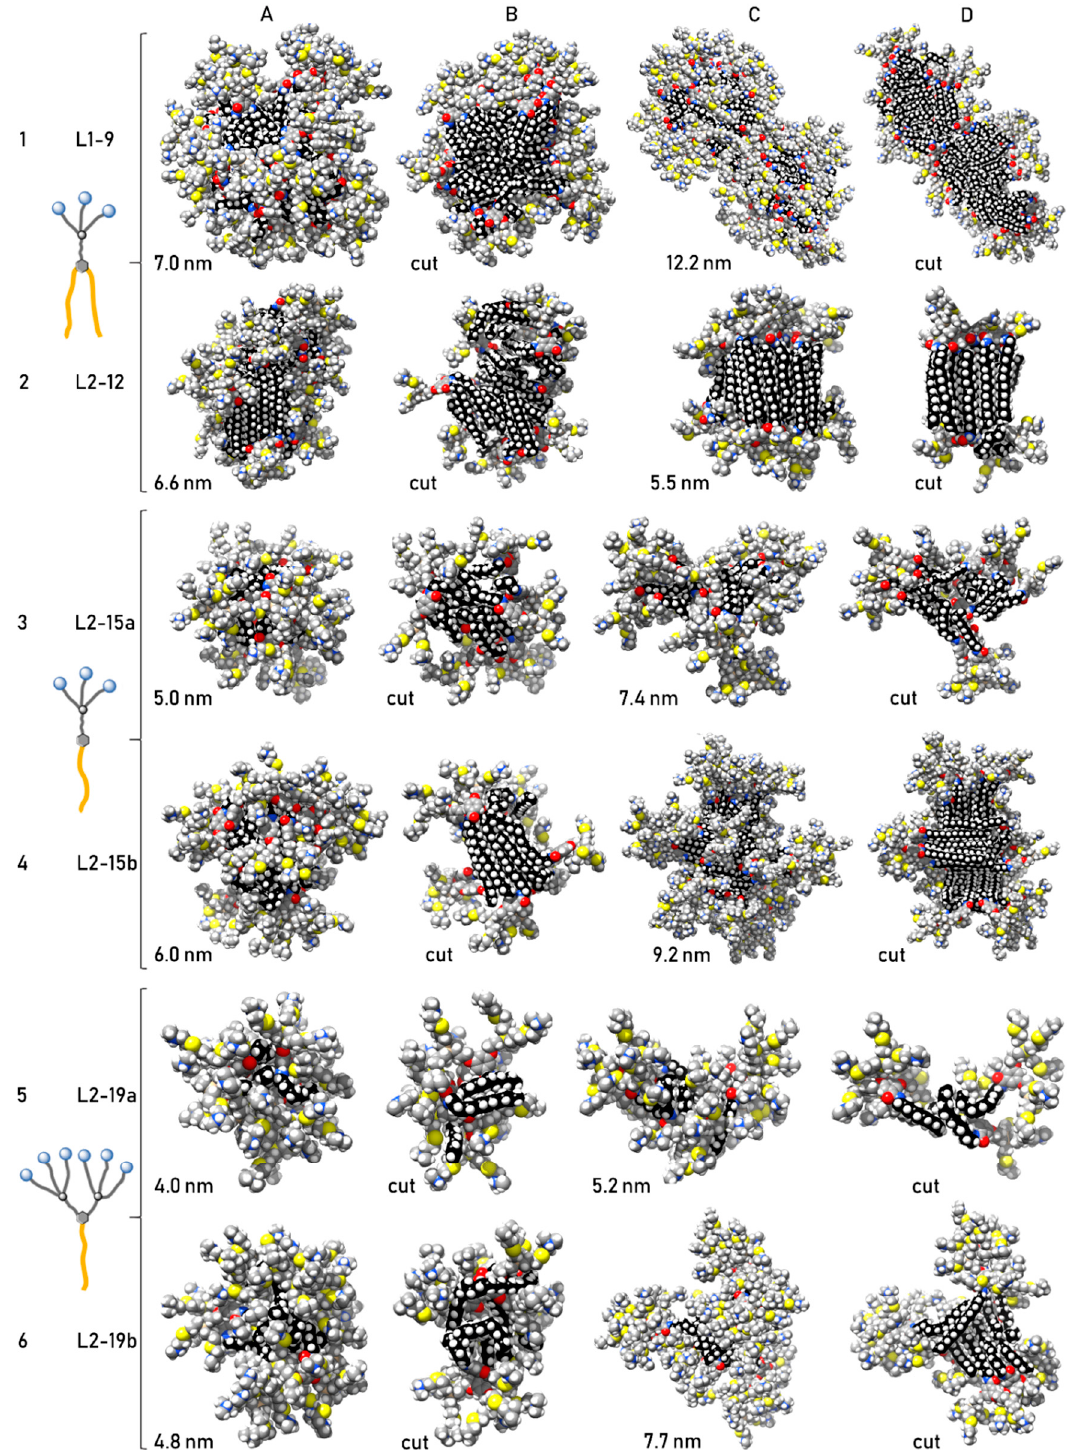
Figure 1. Typical micellar structures composed of ammonium-terminated dendrons L1 – 9 , L2 – 12 , L2 – 15a , L2 – 15b , L2 – 19a and L2 – 19b (lines 1–6 in that order), obtained from molecular dynamics simulations. For each dendron, two representative micellar structures are shown (columns ( A , C )). Each dendron cluster is appended by its cut (on the right from cluster figure; columns ( B , D )), realized by removing a surface layer of dendrons from the cluster. Aliphatic chain carbons are highlighted in black. Colors: C—gray/black; O—red; H—white; Si—beige; N—blue; S—yellow. A very similar effect of the length of aliphatic chains on the internal structure of micellar clusters can be observed also in the case of dendrons L2 – 15a and L2 – 15b having